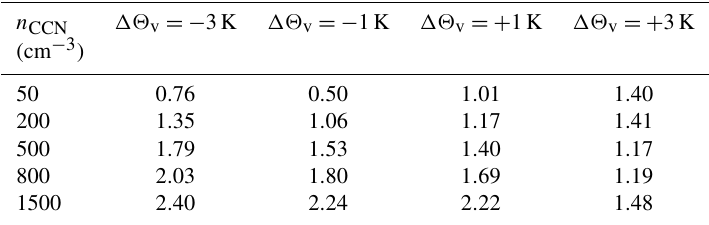
Table 1. Temperature sensitivity α P (in %K − 1 ) of 24h rainfall P for all n CCN values. n